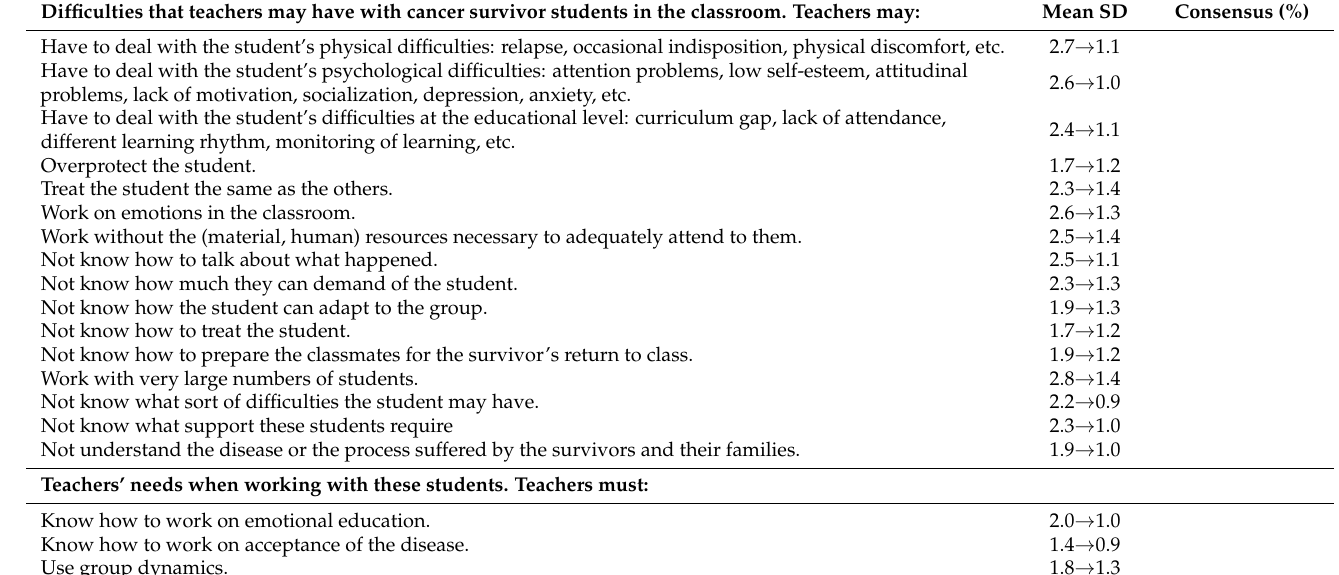
Table 4. Results from Round